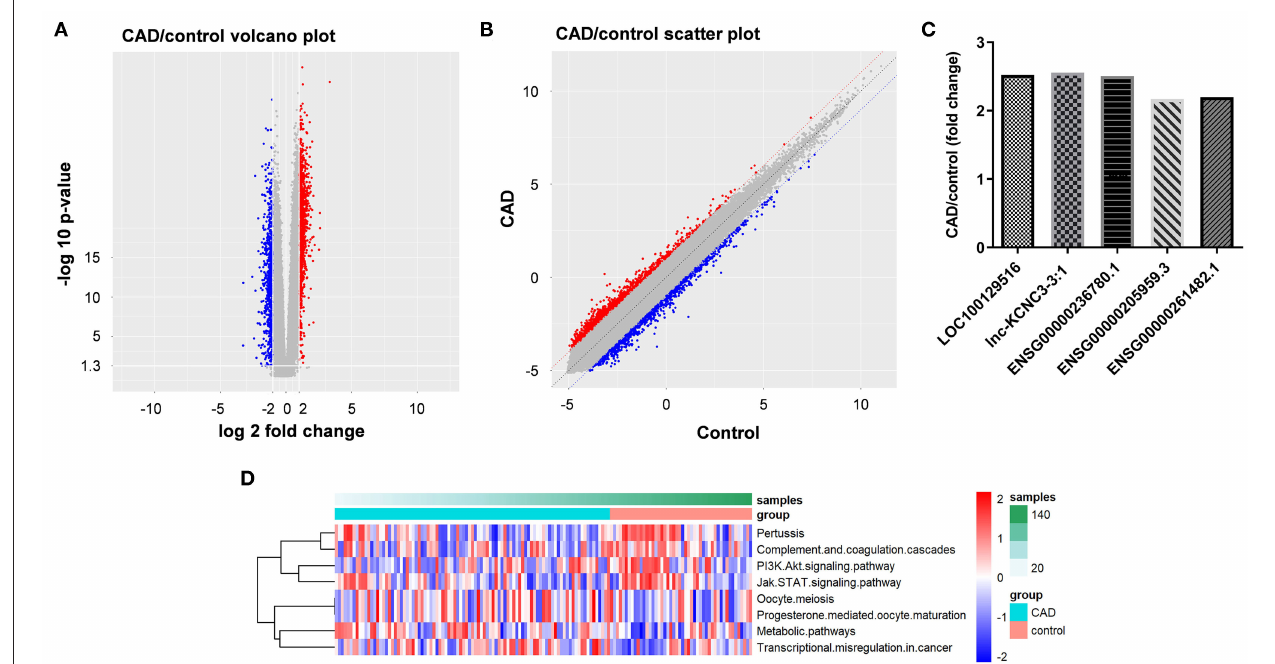
FIGURE 1 | Identification of DEGs between patients with CAD and healthy controls. (A,B) DEGs between patients with CAD and healthy controls were analyzed by R language. The DEGs were presented in volcano plot and scatter plot. The red dots represent genes that are significantly upregulated, and the blue dots represent genes that are significantly downregulated. (C) LncRNA-related genes were analyzed by GSVA method to obtain their related pathways. (D) RT-qPCR was used to detect the expression levels of LOC100129516, lnc-KCNC3-3:1, ENSG00000236780.1, ENSG00000205959.3 and ENSG00000261482.1.